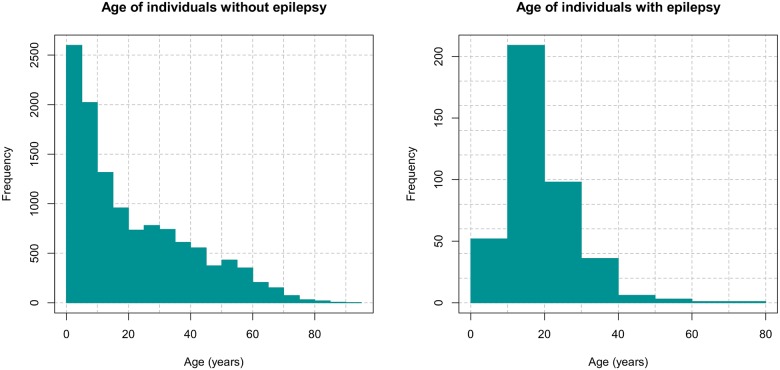
Histograms showing the distribution of ages in persons without (left) and with epilepsy (right).